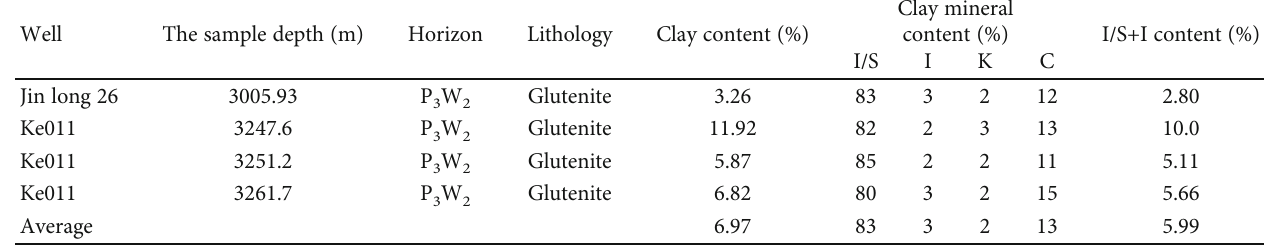
Table 1: X-ray di ff raction quantitative analysis statistics table of Wu 2 section in well Ke017. Well The sample depth (m)